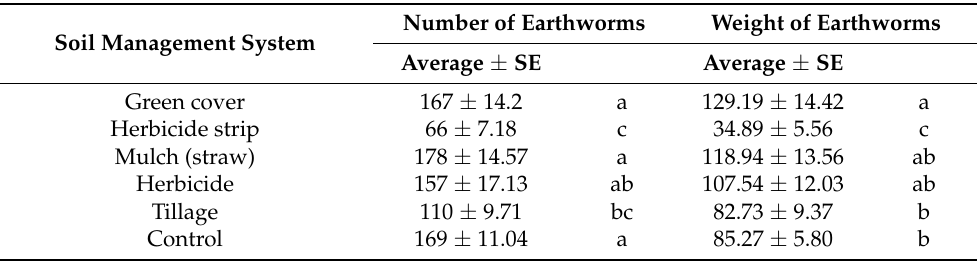
Table 1. Abundance and biomass (g) of earthworms per m 2 in soil with different soil management practices in the period from 22 May 2014 to 5 October